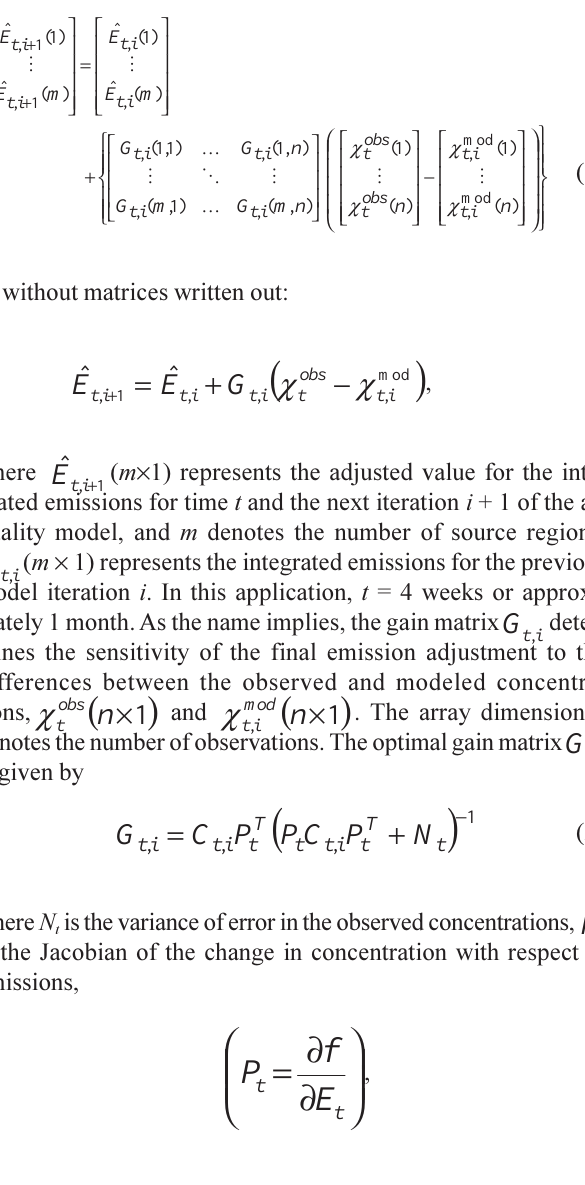
National Emission Inventory NH Estimates[1] by Major Sources (thousand short